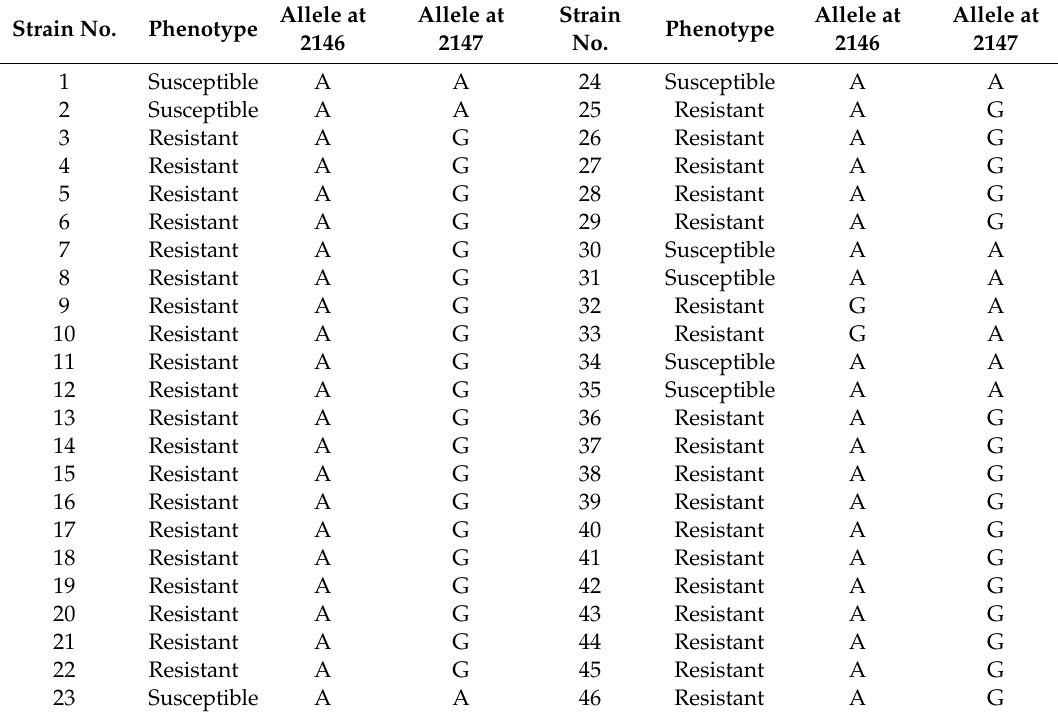
Table 1. Phenotypic resistance to clarithromycin and alleles at nucleotide positions 2146 (formerly 2142) and 2147 (formerly 2143). Strain No.